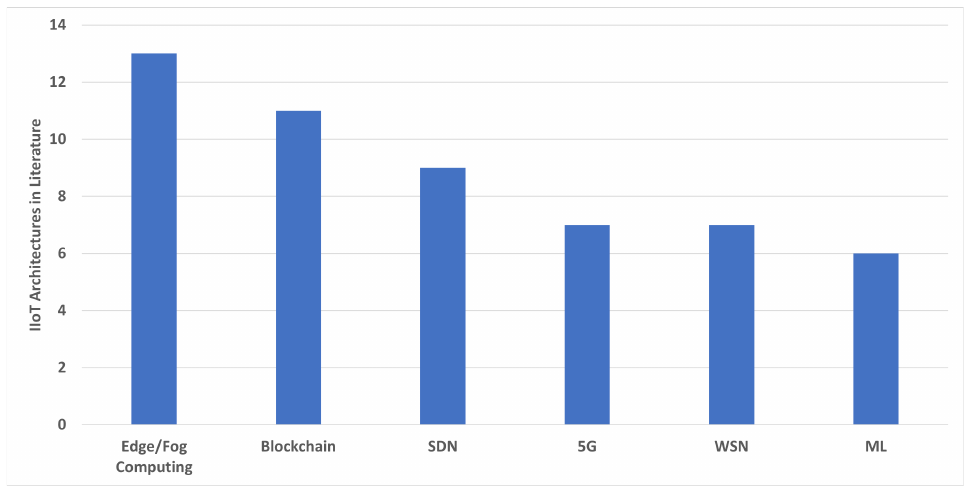
Figure 9. Focus on emerging technologies in the